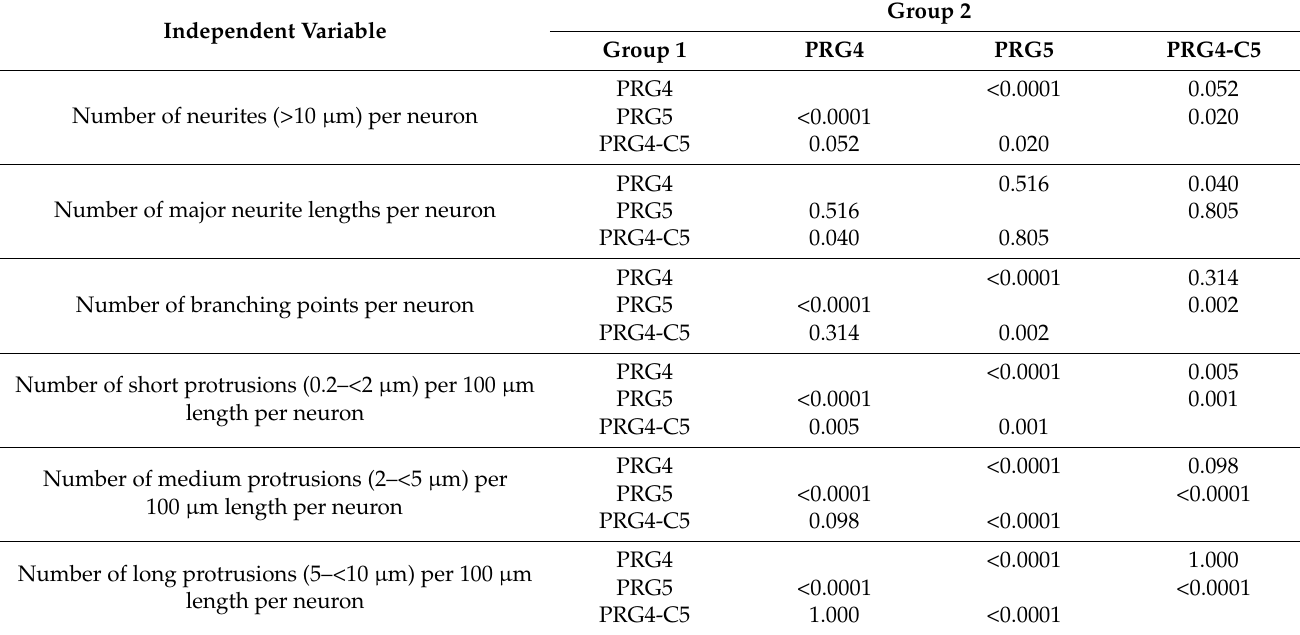
Table 4. Summary of p values of pairwise comparisons obtained by the Kruskal–Wallis test followed by a post hoc Dunn’s test of data presented in Figure